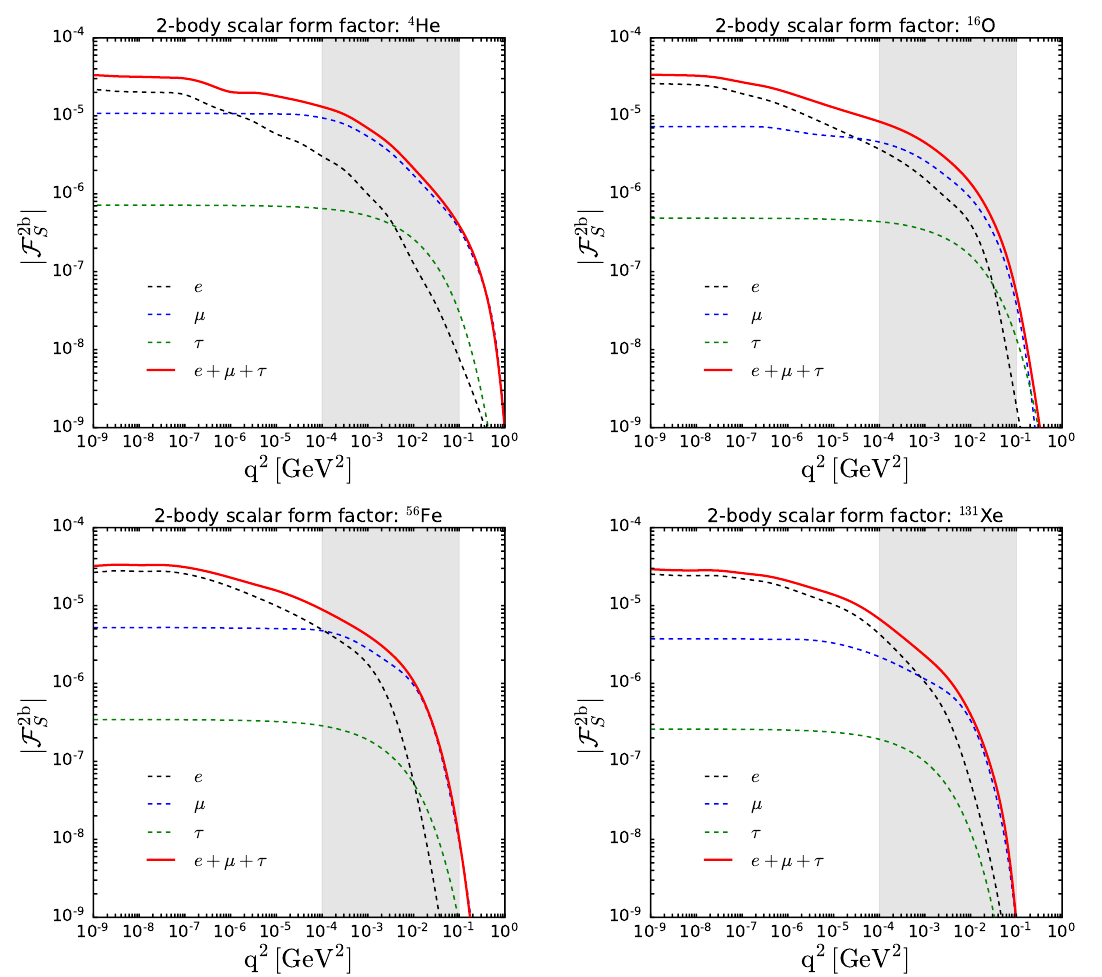
( t ; m ) , for two-body interactions, as a function of the Figure 3. The scalar form factor, F 2b p , m ‘ S square of the exchanged momentum, q 2 ’ − t . We show results for four different nuclei: helium (left upper panel), oxygen (right upper panel), iron (left lower panel) and xenon (right lower panel). Note that, although the factor Z ( Z − 1) / 2 is not included, the result depends on the target. The gray shaded area indicates the range of momentum transfer relevant for scattering processes of local galactic DM off standard